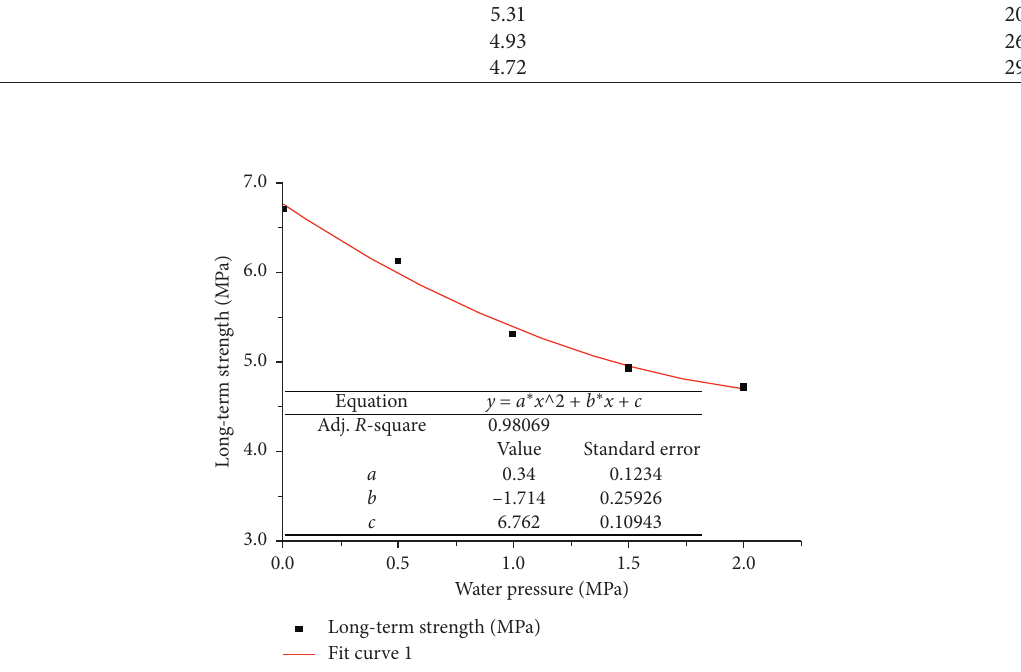
Figure 17: Relationship between long-term strength and water